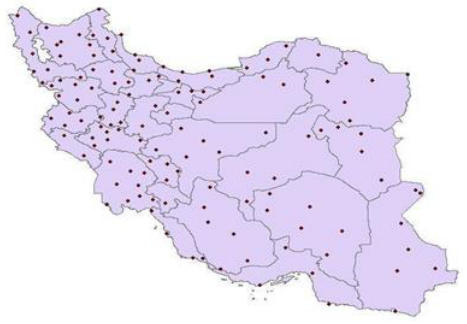
Figure 1. Precipitation stations of